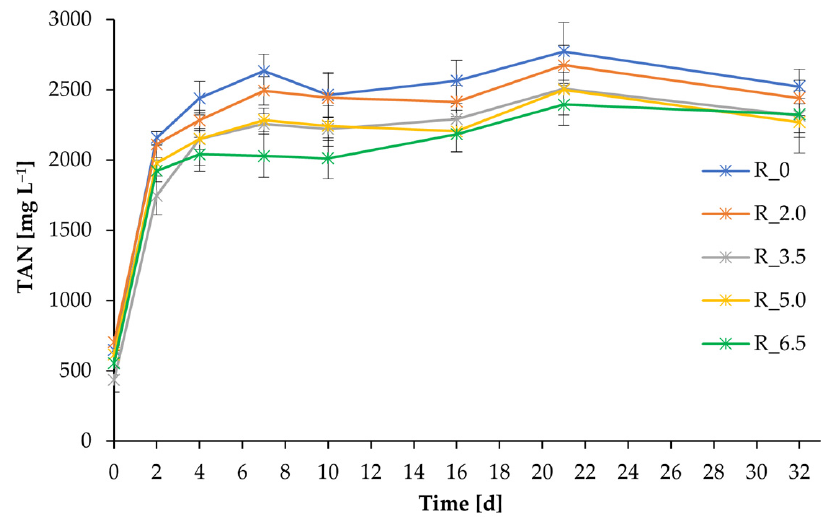
Figure 5. Impact of CNT addition on TAN accumulation during the anaerobic digestion of chicken manure. Different concentrations of CNTs (2.0 g L − 1 , 3.5 g L − 1 , 5.0 g L − 1 , and 6.5 g L − 1 ) were added to the reactors (R_2.0, R_3.5, R_5.0, and R_6.5, respectively). R_0 operated without the addition of CNTs.